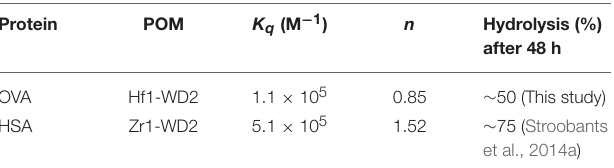
TABLE 1 | Calculated values of the quenching constants ( K q ), their corresponding number of bound molecules ( n ), the percentage of hydrolyzed OVA and HSA (Stroobants et al., 2014a) after 48h incubation at pH 7.4 and 60 ◦ C for different POM-protein complexes.